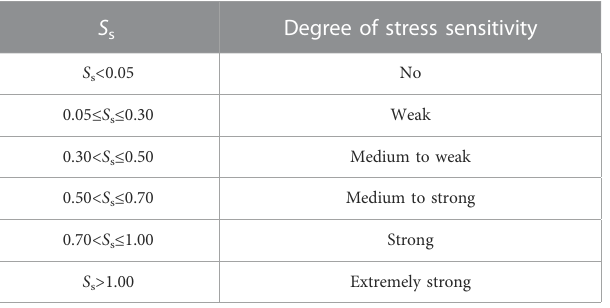
TABLE 1 Evaluation index of stress sensitivity coef fi